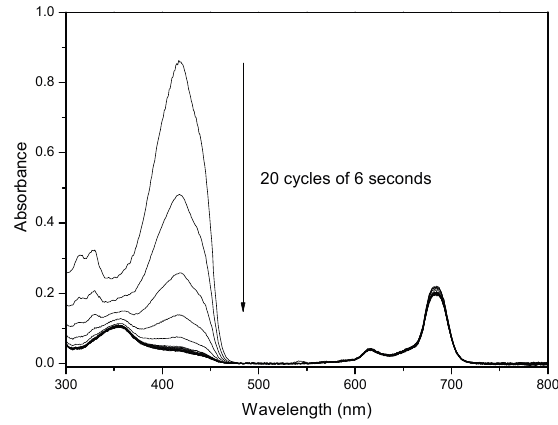
Figure 6. UV-vis spectra of solution containing phthalocyanine ( 12 ) (absorption ~0.2 in 680 nm) and the DPBF (absorption ~0.9 in 418 nm), under constant irradiation by red LED light, obtained after each 6 s period of